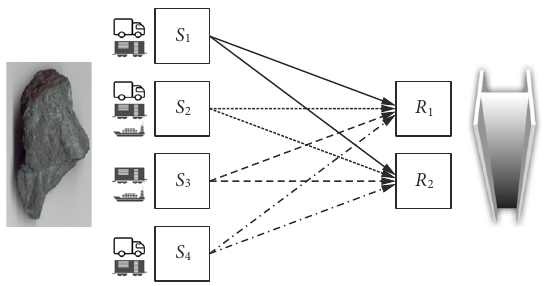
Figure 4. Iranian steel industry